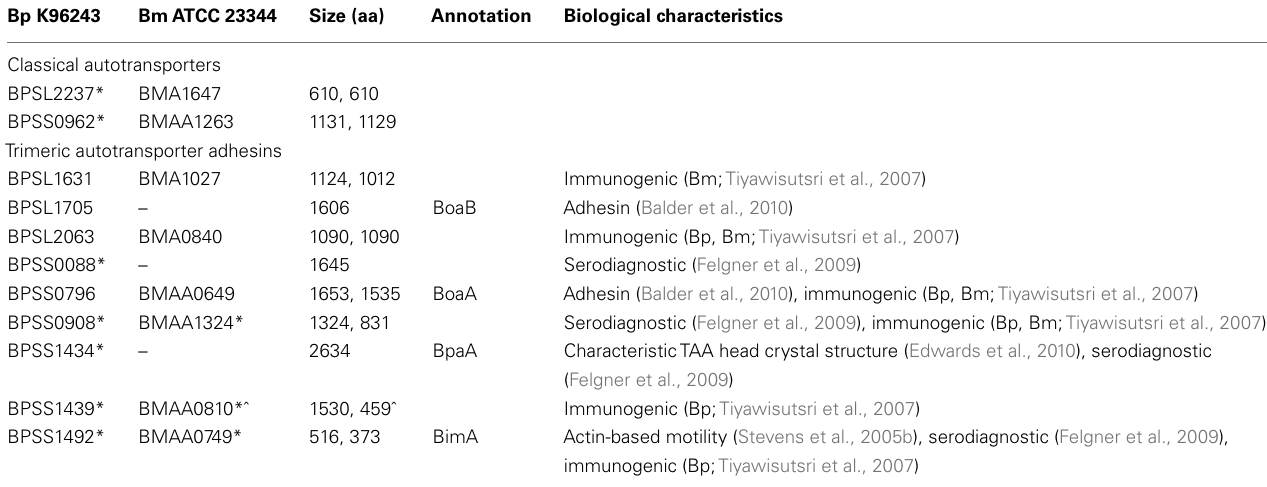
Table 1 | Autotransporters of B. pseudomallei K96243 and B. mallei ATCC 23344.The 11 B. pseudomallei ATs and their eight B. mallei homologs are listed below alongside relevant functional information.